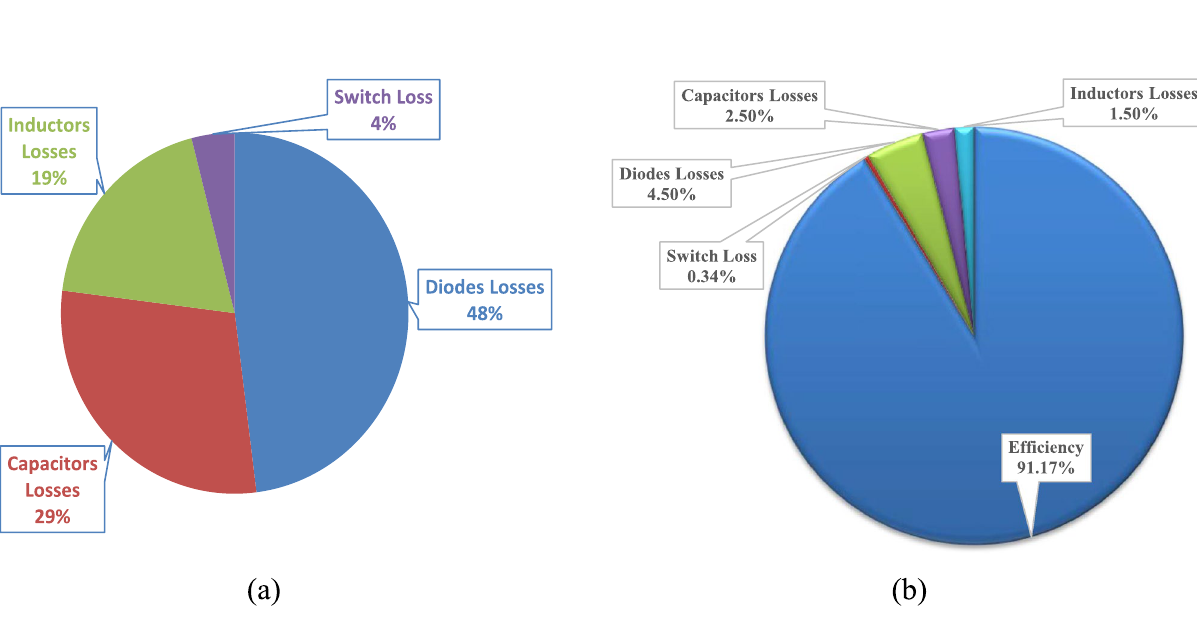
Figure 15. ( a ) Power loss distribution, and ( b ) the efficiency pie chart at a duty cycle of 40%, V in = 24 V and P o = 52 W for converter